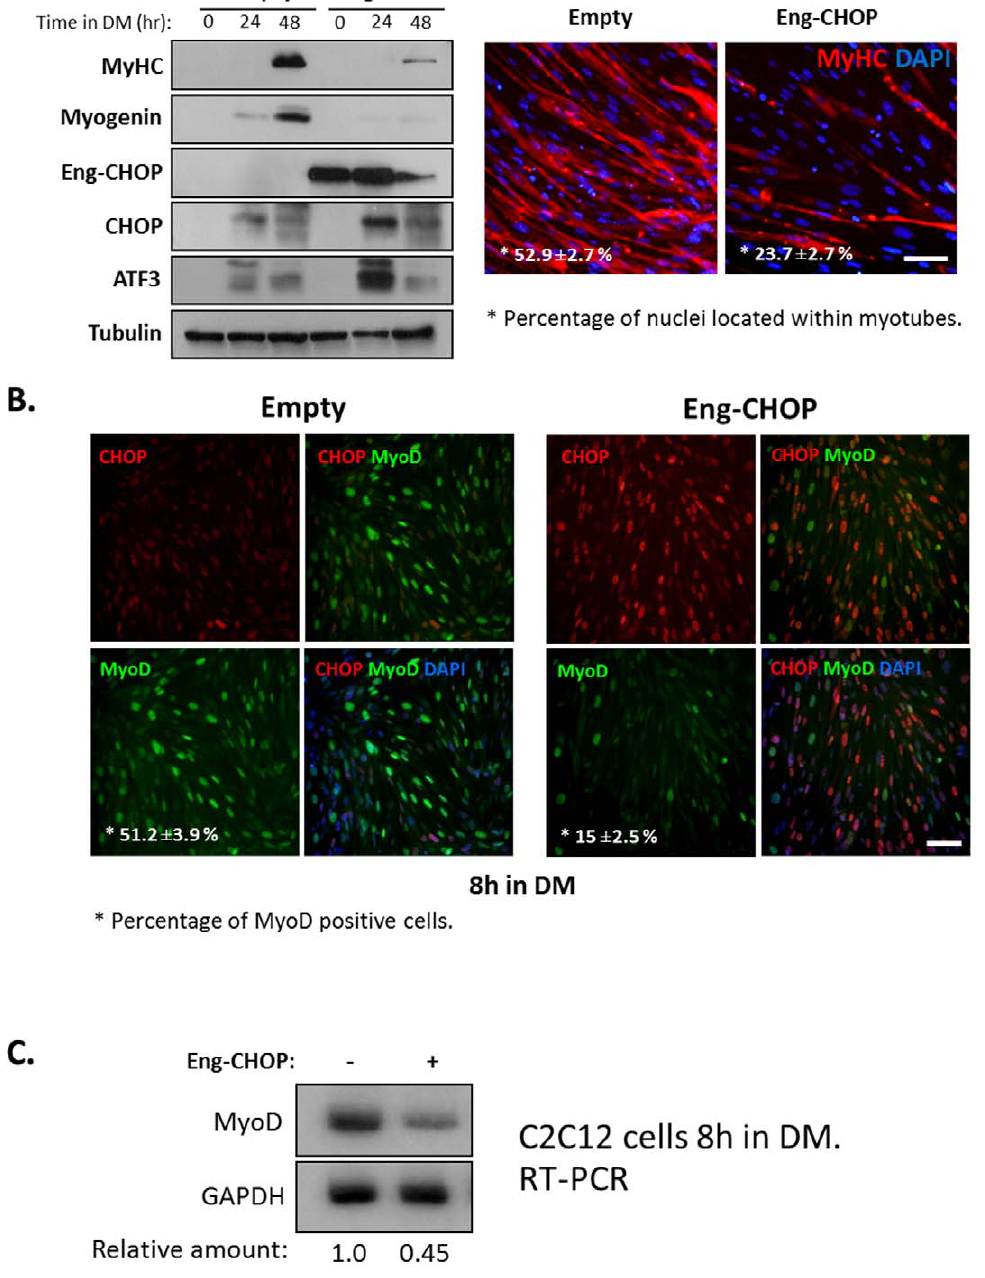
Figure 5. CHOP functions a transcription repressor in myoblasts. (A) A retrovirus encoding a chimera Engrailed-CHOP protein or a retrovirus containing the parental vector was used to infect C2C12 myoblasts. Infected cells were grown in GM and in DM for the indicated time periods and proteins were analyzed by Western blot (left panel). Infected myoblasts were grown in DM for 48 hours and were immunostained with an anti-MyHC antibody (MF20) (right panel). MyHC staining is in red and DAPI is in blue. Percentage of nuclei in myotubes was calculated from three independent experiments. Mean values and standard errors are presented. Bar, 50 m m. (B) Infected cells described in A were grown in DM for 8 hours and were analyzed by immunostaining with antibodies directed against CHOP and MyoD. Control infected cells (left panel) and Engrailed-CHOP infected cells (right panel). Percentage of MyoD-positive nuclei relative to the total number of nuclei was calculated in three independent experiments. Mean values and standard errors are presented. Bar, 50 m m. (C) C2C12 infected cells as in A were grown in DM for 8 hours and total RNA was then extracted. MyoD mRNA levels were analyzed by semi-quantitative RT-PCR and quantified by the posphoimager.